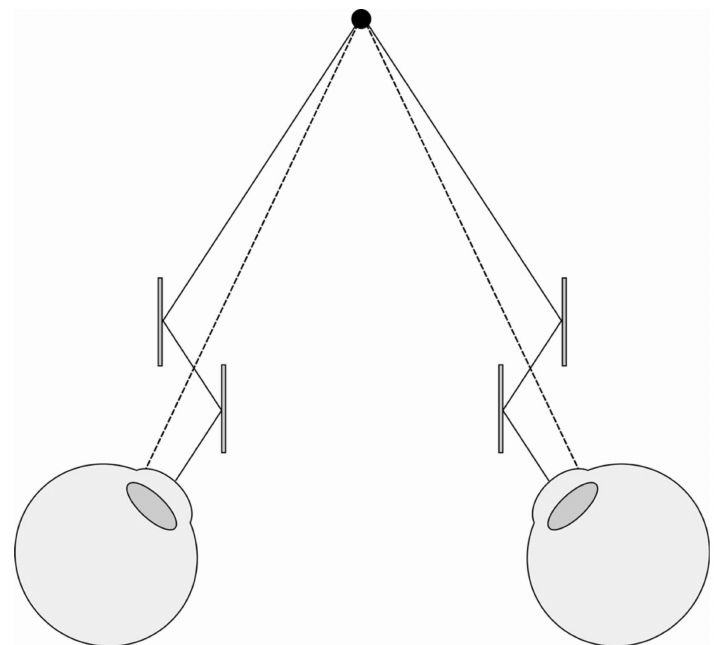
Figure 11. Telestereoscopic viewing. Mirrors alter the path of light to the eyes. In order to view the same point in space, the eyes now have to rotate more (as indicated by the solid line) than they ordinarily would (as indicated by the dotted